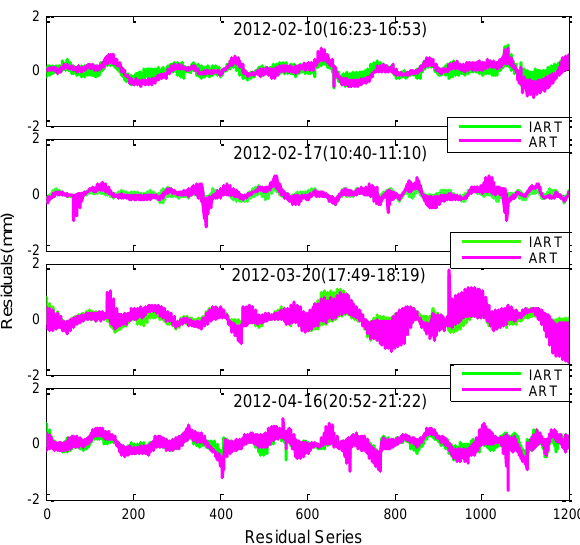
Fig. 3. Slant water vapor (SWV) residuals using GPS data on four days in Hong Kong for IART and ART.